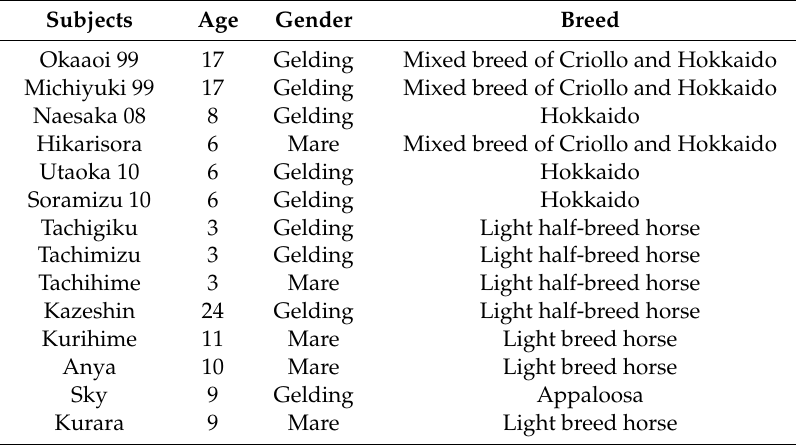
Table 1. Age, gender, and breed of the